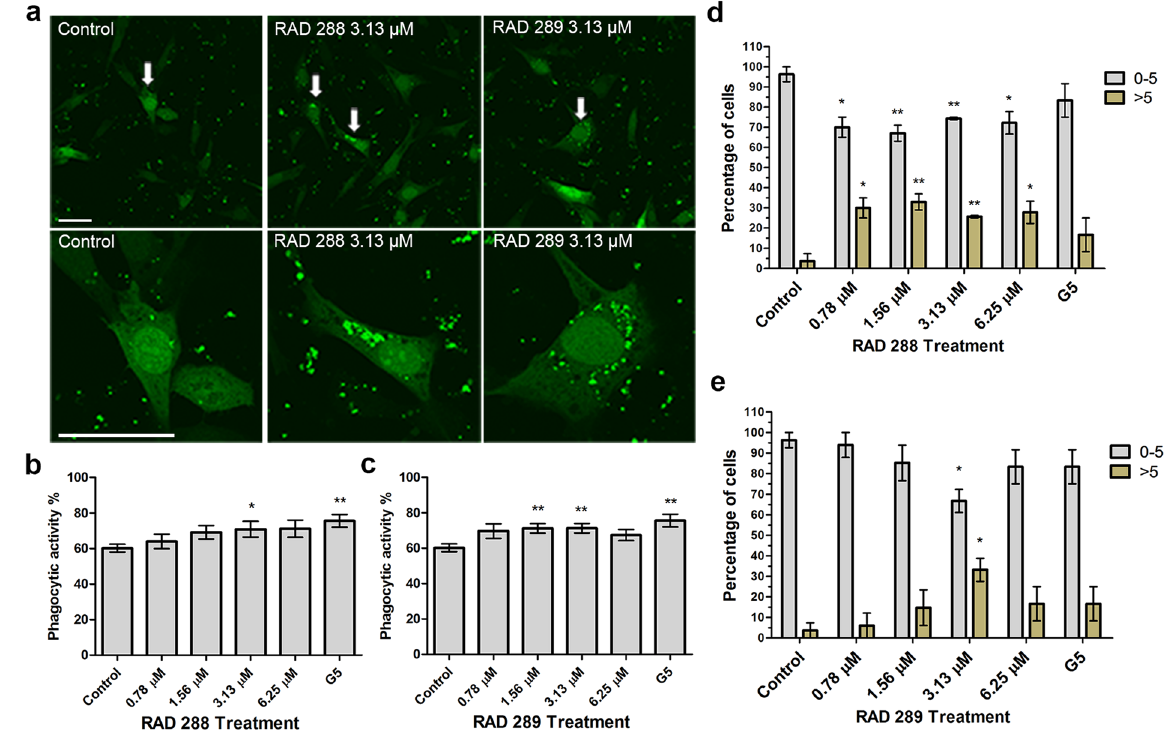
Figure 7. Effect of RAD288 and RAD289 on the phagocytic activity of mOECs. ( a ) Representative images showing RAD288 and RAD289 stimulating phagocytosis of neuron debris compared to control. Scale bar = 50 µ m. ( b ) Phagocytic activity of mOECs after treatment with several concentrations of RAD288. ( c ) Phagocytic activity of mOECs after treatment with several concentrations of RAD289. ( d ) Proportion of mOECs phagocytosing 0 to 5 particles of neuronal debris and more than 5 particles of neuronal debris after treatment with several concentrations of RAD288. ( e ) Proportion of mOECs phagocytosing 0 to 5 particles of neuronal debris and more than 5 particles of neuronal debris after treatment with several concentrations of RAD289. Values are presented as means ± SEM of three independent experiments.